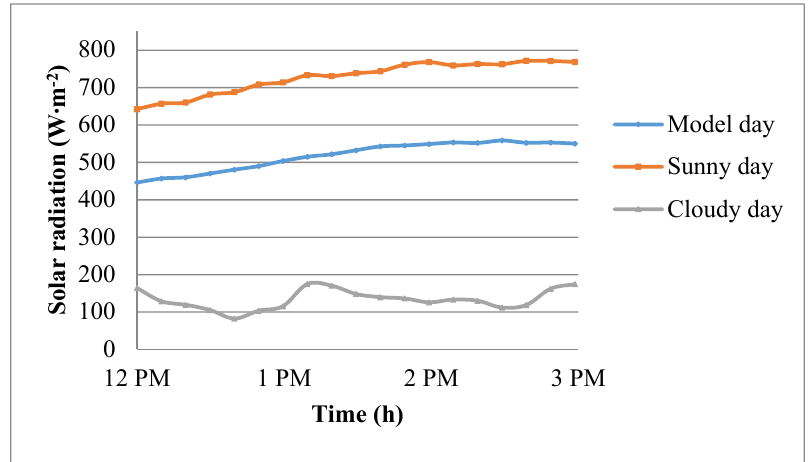
Figure 14. The relations for solar radiation intensity during the sunny, cloudy, and model day. Relative humidity was measured in the exterior and interior. The exterior humidity varies from 64.0% to 78.7%. The highest difference between the exterior and interior relative humidity was 19%. Figure 15 displays relations for ambient temperature and winter season to 3.15 kWh ∙ m − 2 during the summer. From summary results, it is clear that relative humidity during the year. There was no confirmed correlation between mentioned parameters because of a very small correlation coefficient, − 0.618. The interesting results were identified during the model day in October presented in Figure 16. The correlation was near 1. The connection between exterior and interior humidity during the spring and autumn is also evident from values in Table